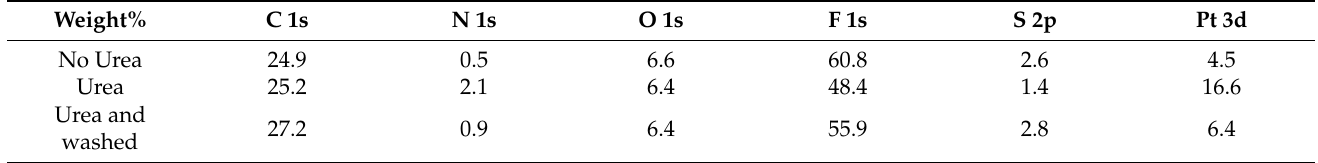
Table 1. Elemental composition of the graphene-based MEAs calculated from XPS results. MEAs were sprayed with urea added to the ink and no urea for comparison; in addition, XPS data were obtained for the urea-sprayed MEAs before washing. XPS spectra are provided in Supplementary Materials (Figures